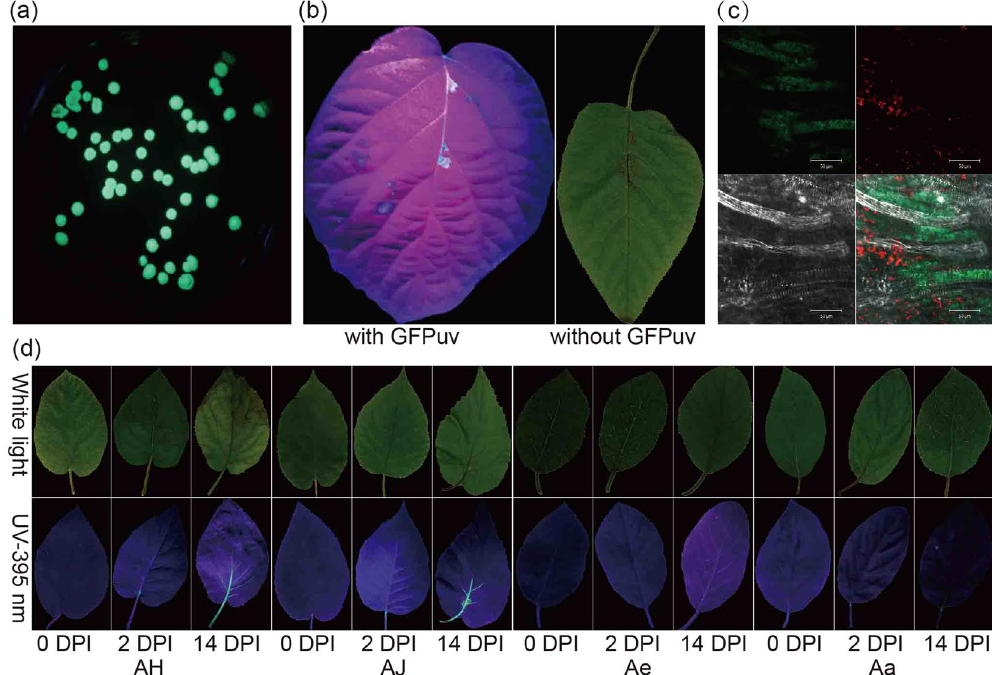
Figure 1. Visualization of GFPuv-labeled Psa and leaf symptoms of kiwifruit infected with transformed Psa. ( a ) Psa strain C48 transformed with GFPuv. ( b ) Leaf symptoms of Hongyang (AH) with invasion of C48 showing no effect on the toxicity of GFPuv-transformed Psa stain C48. ( c ) An AH leaf collected at 14 days post inoculation (DPI) examined under a Leica confocal laser scanning microscope with excitation at 488 nm and emitted light collected from 500 to 600 nm. Images were captured of green fluorescence (upper left), autofluorescence (upper right), natural light (low left) and combined image (low right). ( d ) Leaf symptoms of kiwifruit samples during Psa infection. Photographs were taken under natural light (upper panels) and UV light (395 nm, low